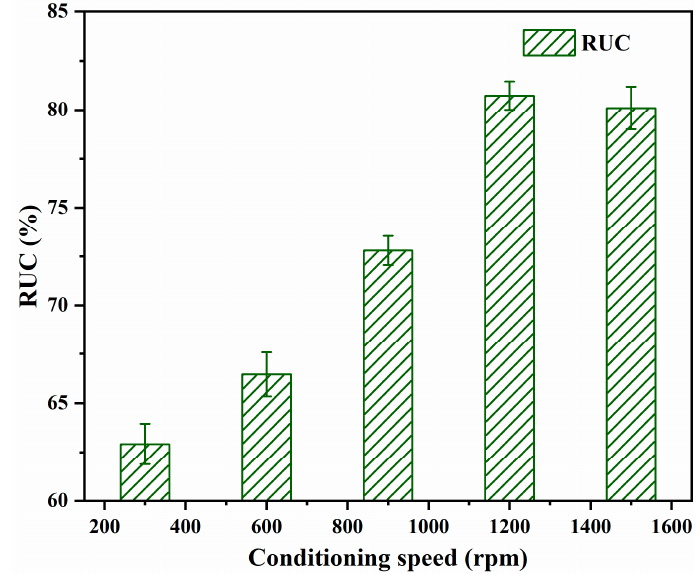
Figure 11. Effect of different conditioning speeds on the RUC of the flotation tests.